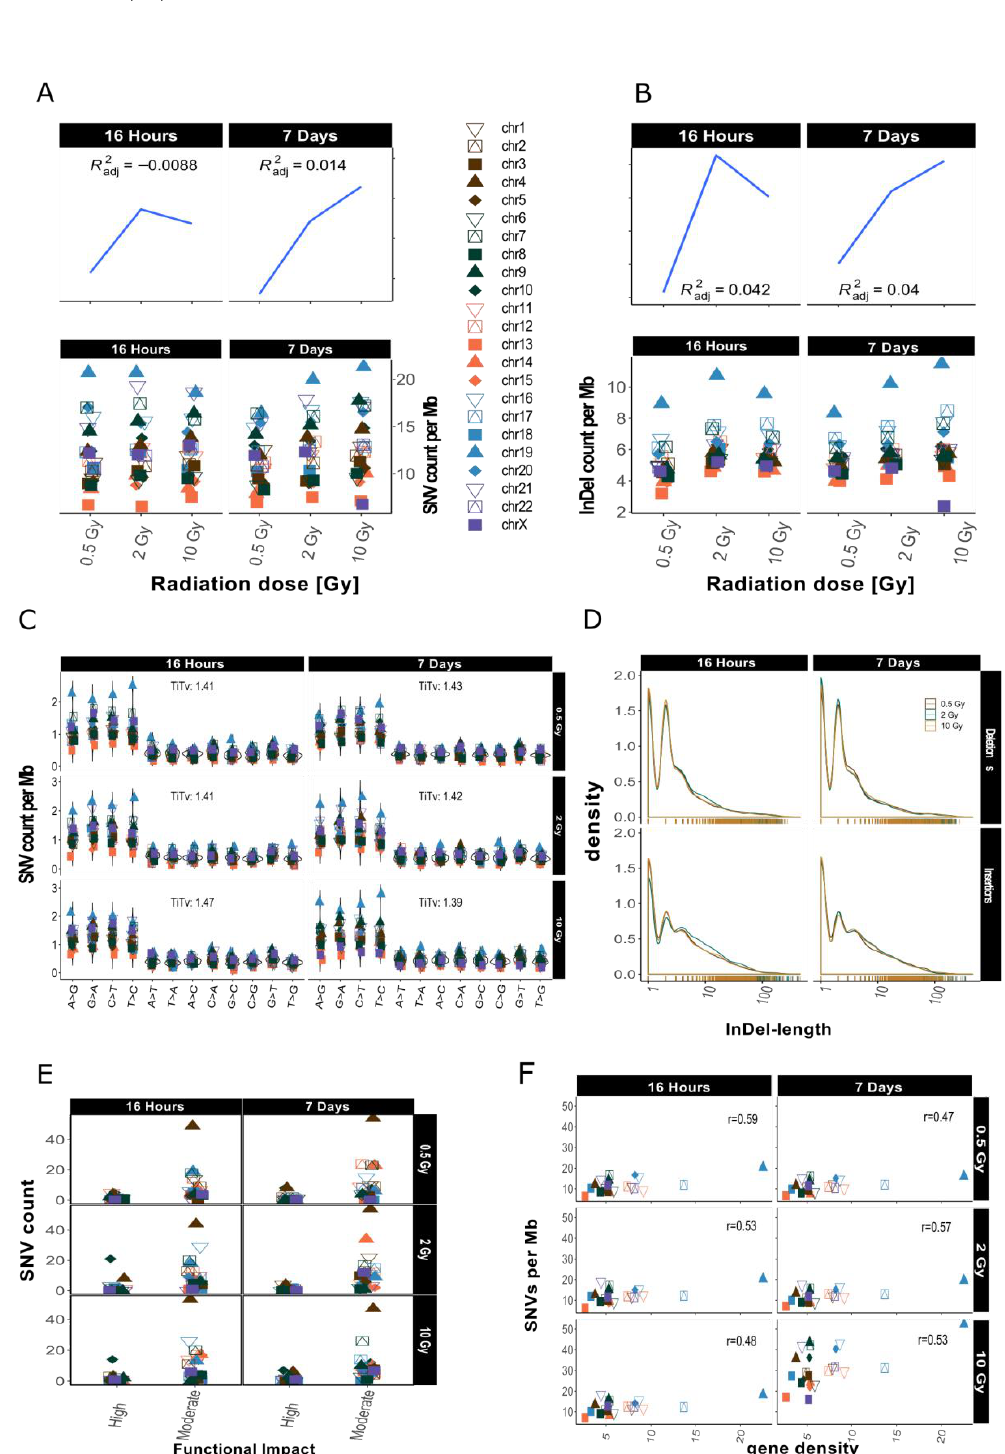
Figure 2. Overview for IR-induced SNV accumulation in genome dataset 1 (for genome dataset 2 see Appendix A Figure A2). Accumulation of SNVs per Mb (( A ), lower panel) and InDels per Mb (( B ), lower panel) per chromosome is shown together with the corresponding trends with adjusted root mean square (upper panels). ( C ): SNV types, i.e., as transitions (Ti) and transversions (Tv) per MB per chromosome and Ti / Tv values for each sample. ( D ): Distribution of insertions and deletions with respect to size. ( E ): SNV count per chromosome with respect to functional impact (HIGH and MODERATE functional consequences only). ( F ): SNVs per Mb per chromosome with respect to relative chromosomal gene density. Gene density was computed based on hg19 (GRCh37) using the custom gene set (excluding predicted genes) described b